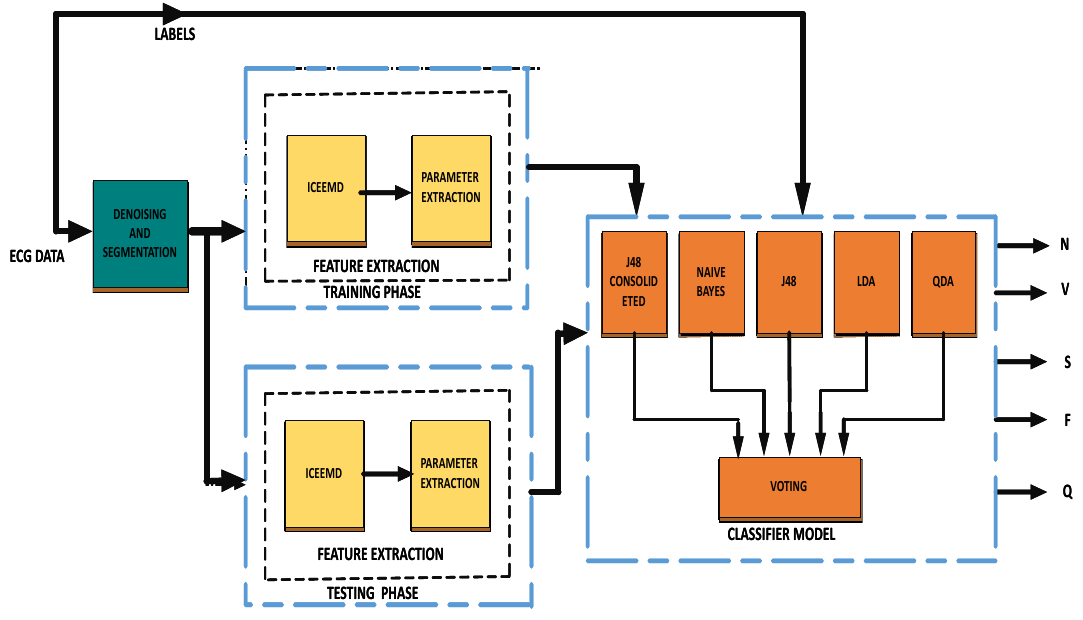
Figure 1. Block diagram of the proposed